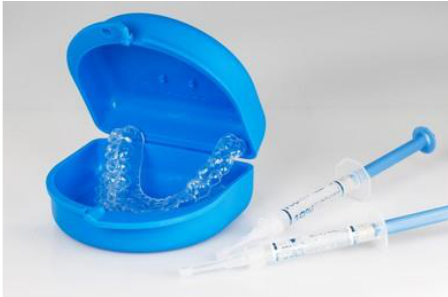
Figure 3. Home bleaching kit with a tray which is worn at night until the desired tooth shade is achieved.